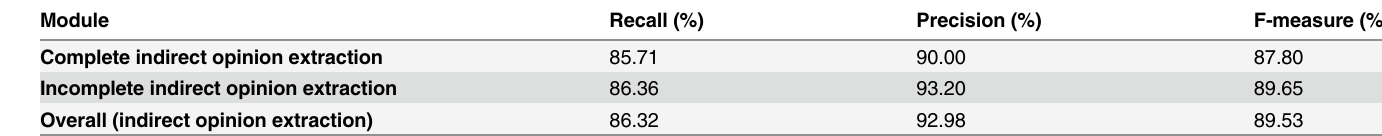
Table 4. Performance of the indirect opinion extraction modules